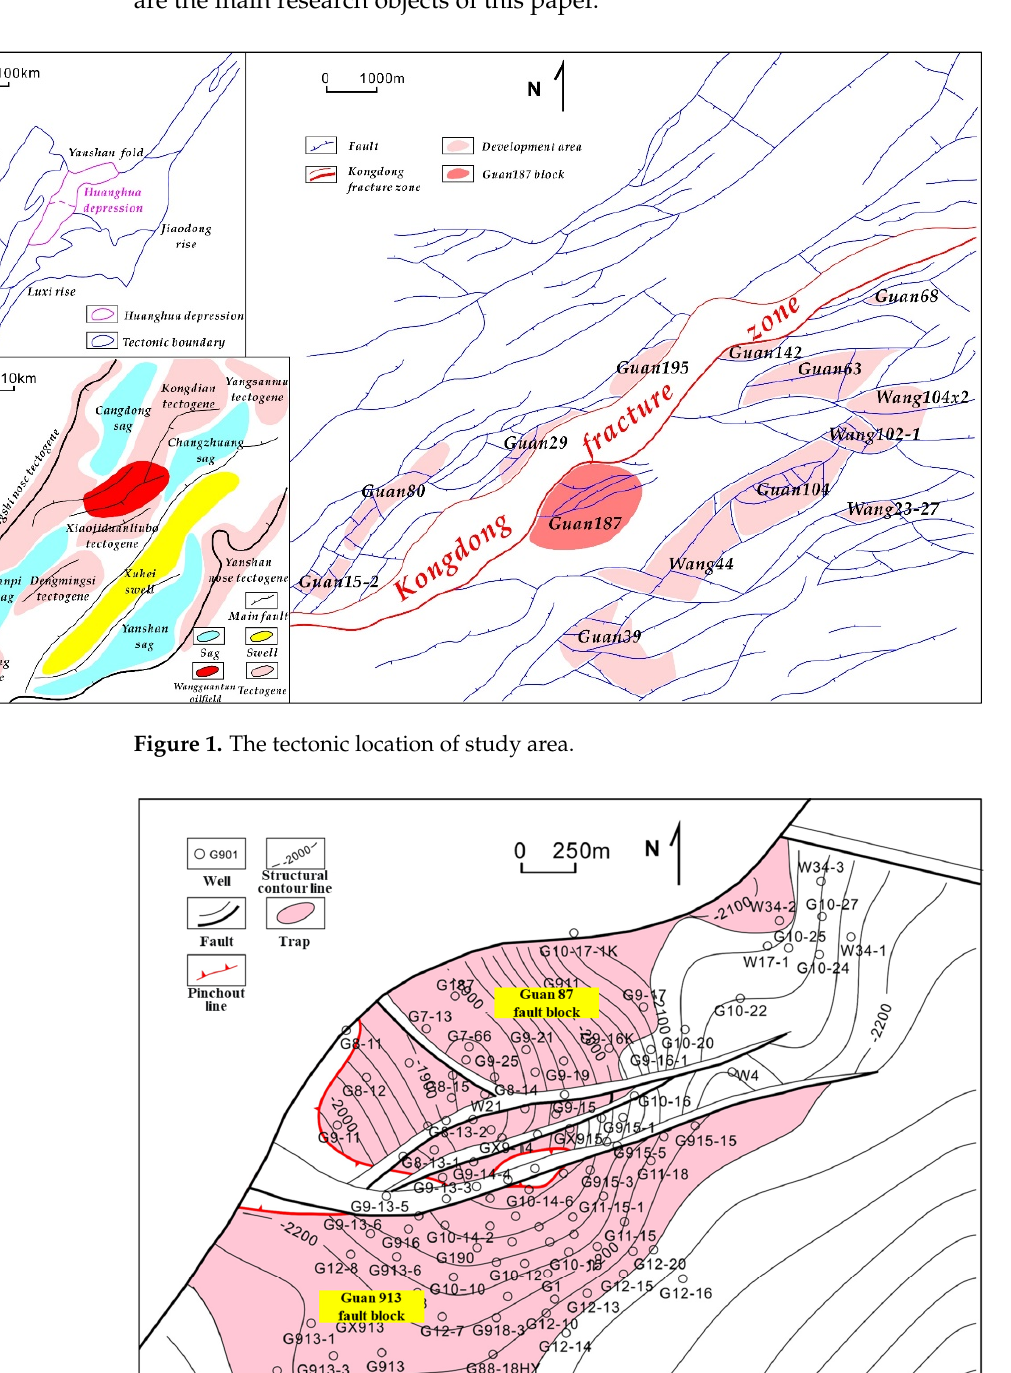
Figure 2. Top structural map of Es33 in Guan187. Located in the east of the Kongdong fault zone and controlled by the Kongdong fault, the Guan187 area is high in the north and low in the south, and its interior is divided by several faults [16,17]. The whole study area is divided into the northern Guan187 fault block and the southern Guan913 fault block by the central fault. The highest point of the structure in the whole area is near well G187, which gradually decreases to the four sides, forming an anticlinal trap. There is a secondary high near Wang 34-2, which gradually decreases to the four sides (Figure 2). The target horizon of this paper is the third oil formation of the third member of Shahejie Formation, which belongs to the Shahejie Formation. The lower strata are the Paleogene Kongdian Formation, and the upper strata are the Dongying Formation, Guantao Formation, and Minghuazhen Formation. In the Shahejie Formation, the lower part of the first member of the Shahejie Formation and the third member of the Shahejie Formation are the main oil-producing reservoirs in this area. The third member of the Shahejie Formation can be subdivided into three oil groups. Affected by paleotopography, strata in the study area show a trend of thickening in the south and thinning in the north, with large thicknesses in low parts and thin thicknesses in high parts as a whole. The thickness of sandstone in the reservoir also has a certain thinning trend. There are a large number of thin layers of light green fine sandstone and argillaceous siltstone in the third oil formation of the third member of the target formation, which are mainly characterized by “mud-coated sand”. The upper part of the Sha32 oil Formation contains a set of stable volcanic rock sedimentary layers, and the lower part of the Zao 0 oil Formation of the first member of the Kongdian Formation is lake deposition, with a set of stable paste rock lay- ers. Therefore, the target interval can be accurately identified and divided. Most of the wells can be drilled into the third oil group of the third member of the Shahejie Formation. In some areas, due to the influence of the central fault, the target strata have a formation loss phenomenon to varying degrees (Table 1).